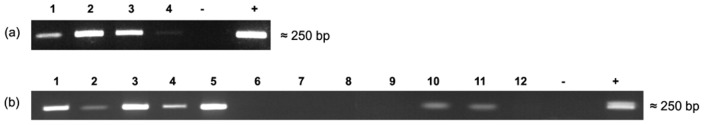
Expression of specific SP-G mRNA amplification products.The following samples were used: A) lacrimal gland [1], eyelids [2], conjunctiva [3], cornea [4]; B) lung [1], eyelid [2], heart [3], kidney [4], testis [5], stomach [6], spleen [7], nasal mucosa [8], salivary gland [9], umbilical cord [10], trophoblast [11], liver [12]; (−) negative control without template cDNA and (+) positive control – plasmid DNA carrying the ORF for the respective SP-G. All RT-PCR analyses show cDNA amplification for the corresponding SP in comparison with β -actin.